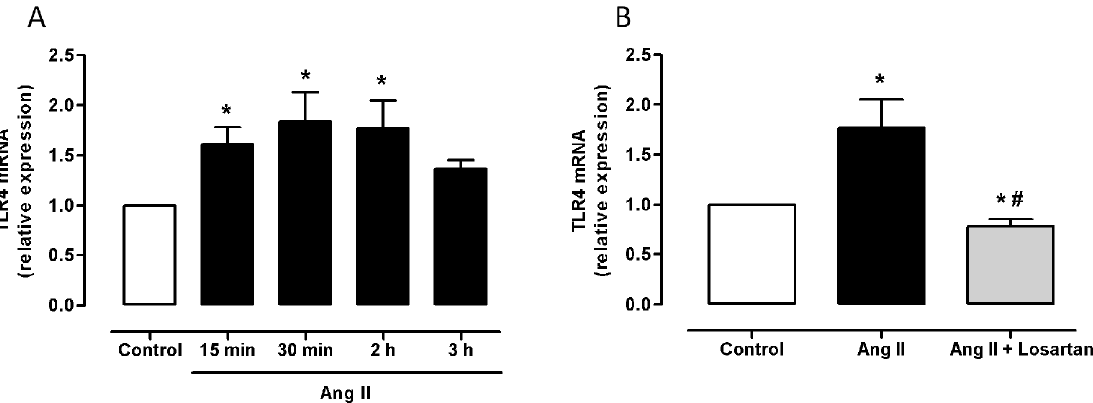
Figure 7. Ang II upregulates TLR4 expression in SHR VSMCs via the AT 1 receptors. (A) Effect of Ang II (100 nM, 15 min-3 h) on TLR4 mRNA levels in SHR VSMCs. (B) Effect of Ang II (2 h) on TLR4 mRNA levels in the absence and the presence of losartan (10 m M, 1 h). The results (mean 6 SEM) are expressed as relative expression compared with control. *P , 0.05 vs Control, # P , 0.05 vs Ang II by Student’s t-test. n=4–5.